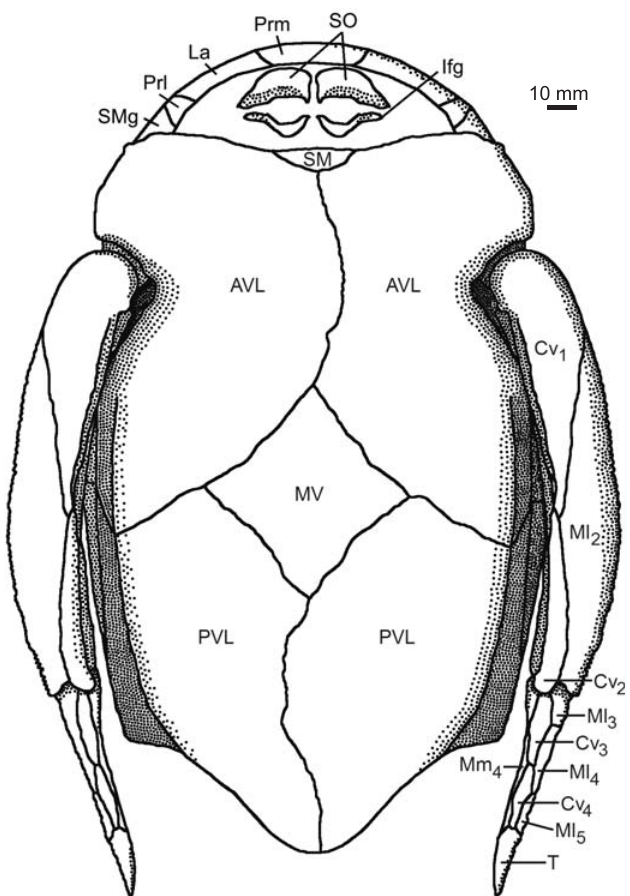
Fig. 14. Antiarchan fish Bothriolepis leptocheira jeremejevi (Rohon, 1900), reconstruction of the head, the trunk armour and the pectoral fins in ventral view, based on IG KSC 155/10-1, IG KSC 155/10-2, and IG KSC 155/10- 3. Abbreviations: AVL, anterior ventro-lateral plate; Cv 1–4 , ventral central plate 1 to 4; Ifg, inferognathal plate; La, lateral plate; Ml 2–5 , lateral marginal plates 2 to 5; Mm 4 , mesial marginal plate 4; MV, median ventral plate; Prl, prelateral plate; Prm, premedian plate; PVL, posterior ventro-lateral plate; SM, semilunar plate; SMg, submarginal plate; T, terminal